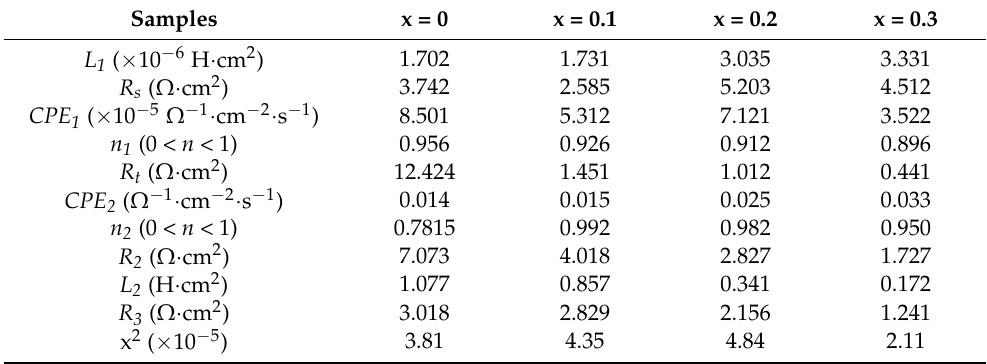
Figure 5. The equivalent circuit of the EIS curve of the Al-1Zn-0.1In-0.1Sn-0.5Mg-xMn (x = 0, 0.1, 0.2, 0.3) (wt.%) alloy anodes in the 4 M NaOH solution. Table 4. The EIS simulated values of the Al-1Zn-0.1In-0.1Sn-0.5Mg-xMn (x = 0, 0.1, 0.2, 0.3) (wt.%) alloy anodes in the 4 M NaOH